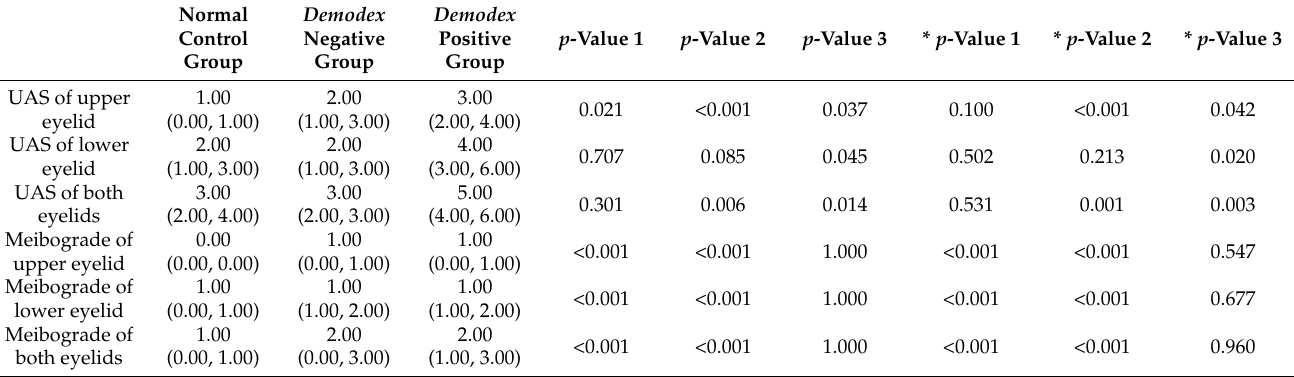
Table 2. Uneven atrophy score and meibograde in three groups.